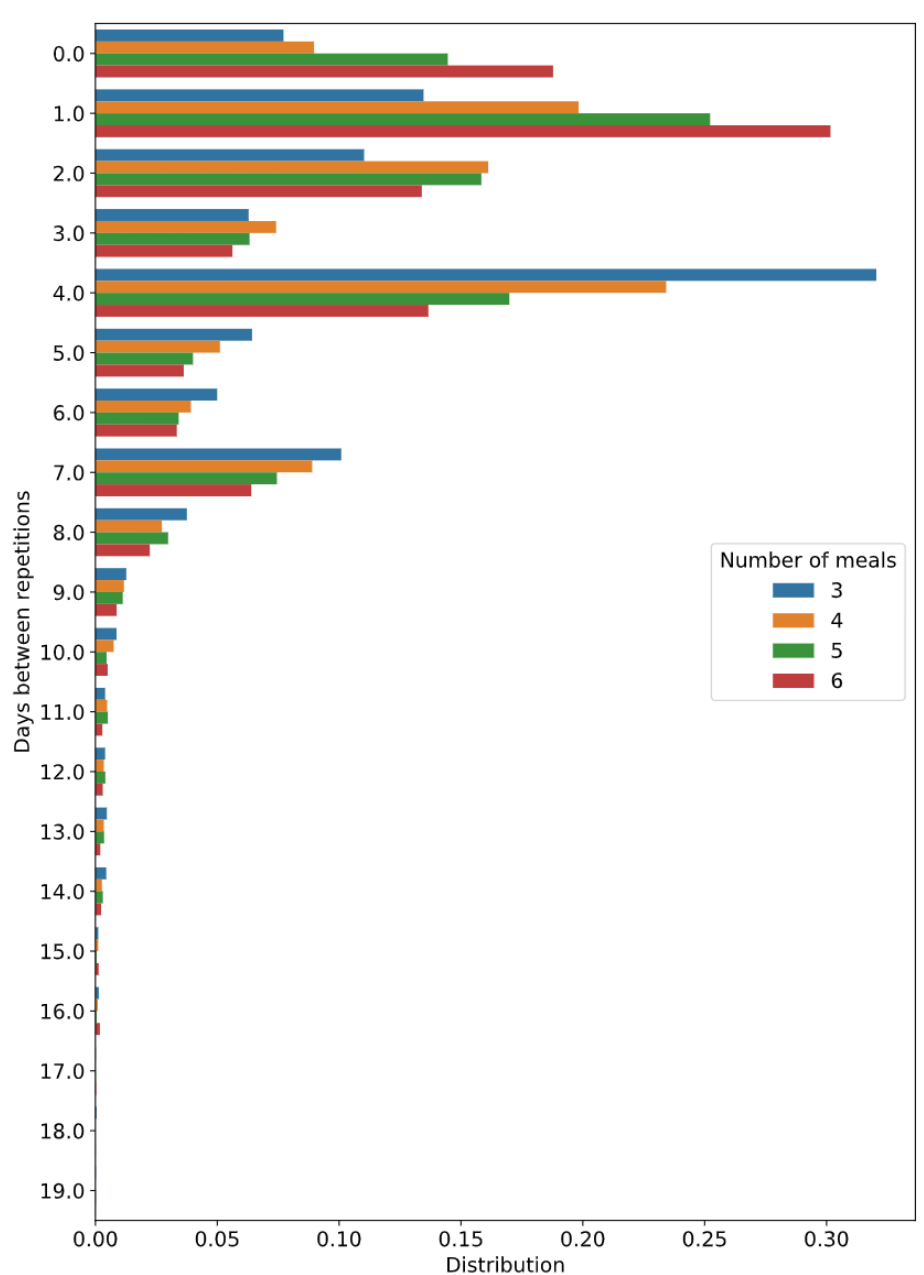
Figure 4. Distribution of the number of days between repetitions for the different numbers of selected